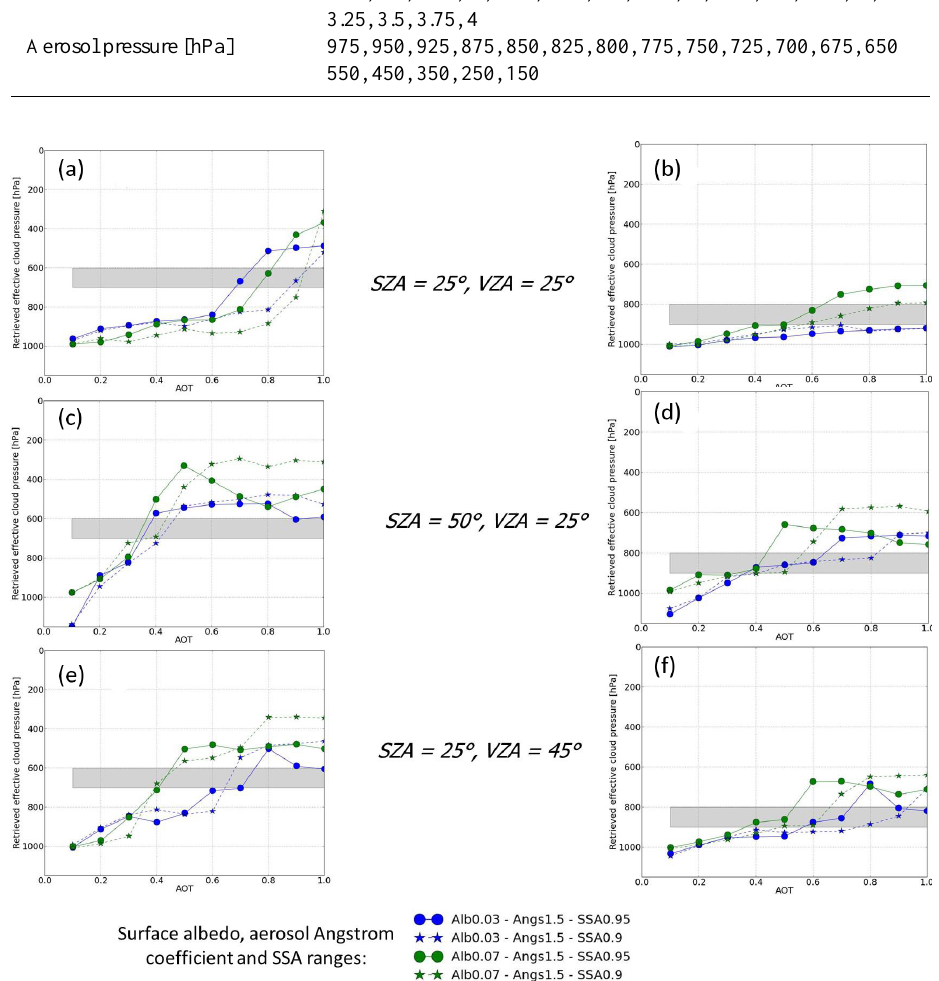
Figure 12. Impact of geometry angles on the effective cloud pressure retrievals as a function of surface albedo, aerosol microproperties, AOT, and location of atmospheric aerosol layers (grey colour depicts the location of the simulated aerosol layers). The same conditions as in Fig. 10a are assumed: (a) and (b) SZA = 25 ◦ and VZA = 25 ◦ , (c) and (d) SZA = 50 ◦ , VZA = 25 ◦ , (e) and (f) SZA = 25 ◦ , VZA = 45 ◦